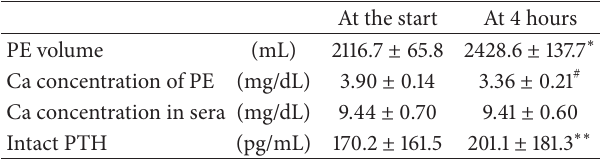
Table 4: Effluent and serum Ca and parathyroid hormone on PET. At the start At 4 hours PE volume (mL) 2116.7 ± 65.8 2428.6 ± 137.7